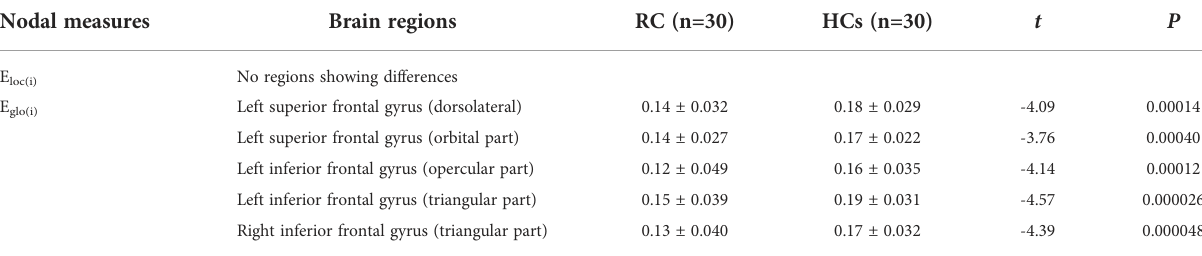
TABLE 3 Brain regions showing differences in the AUC of nodal measures between groups. Nodal measures Brain